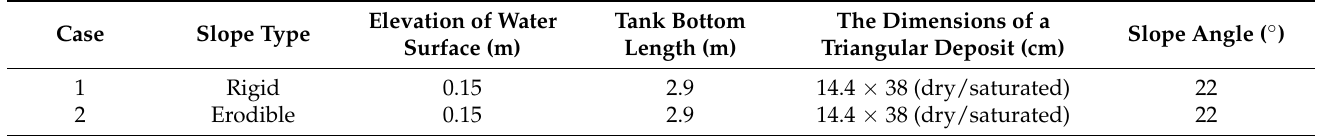
Table 1. Main parameters of the model.